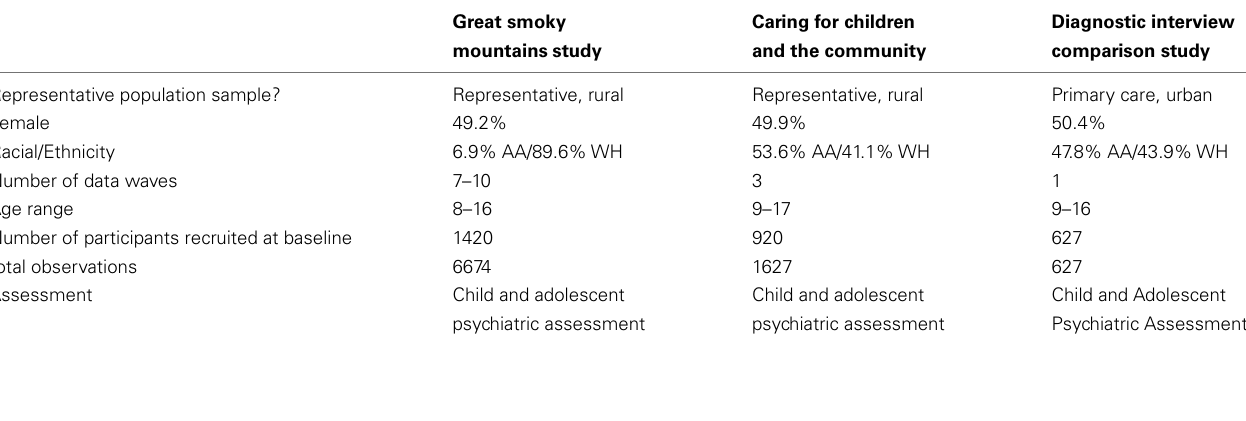
Table 1 | Characteristics of the three community